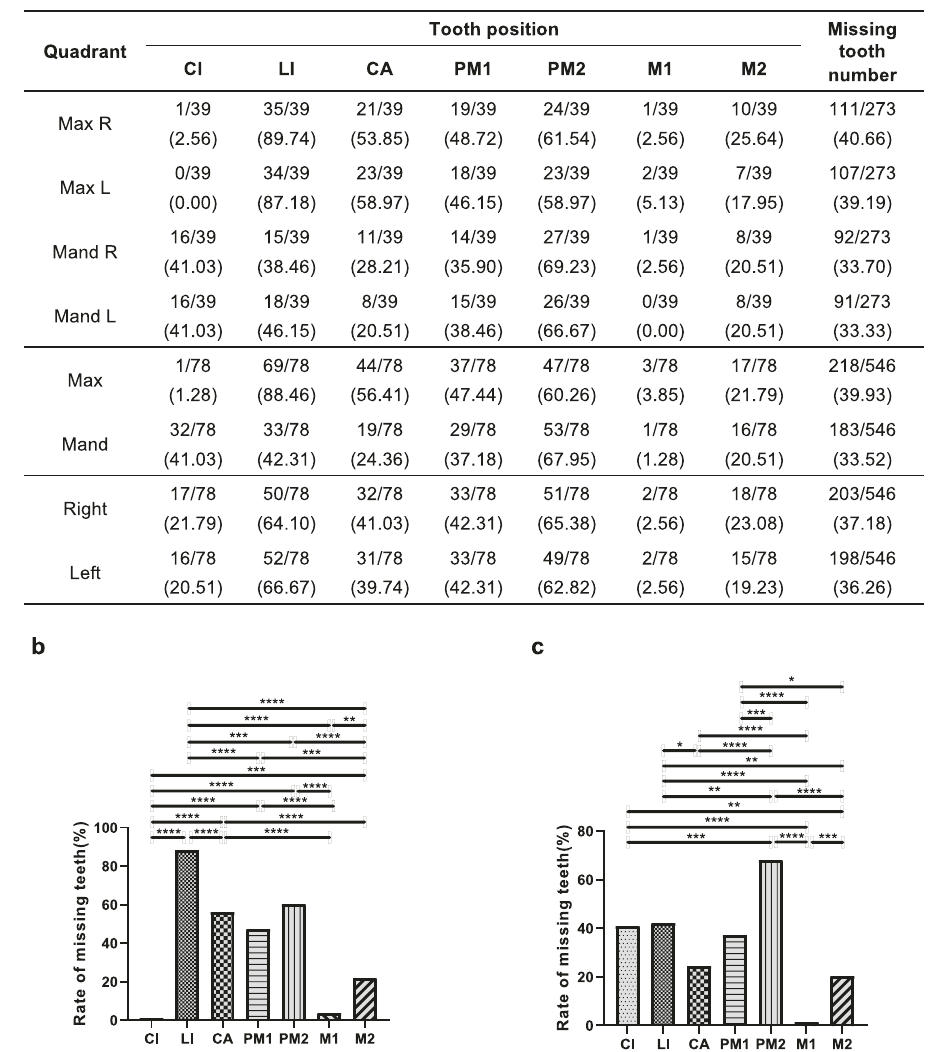
Conservation analysis The LRP6 amino acid sequences of different species were obtained from UniProt. Evolutionary conservation analysis of the pathogenic mutations identi fi ed in this study was performed using the Multiple Sequence Alignment Server (T-coffee). obtained from the Protein Data Bank (PDB) for conformational change prediction. The three-dimensional structures of wild-type and mutant LRP6